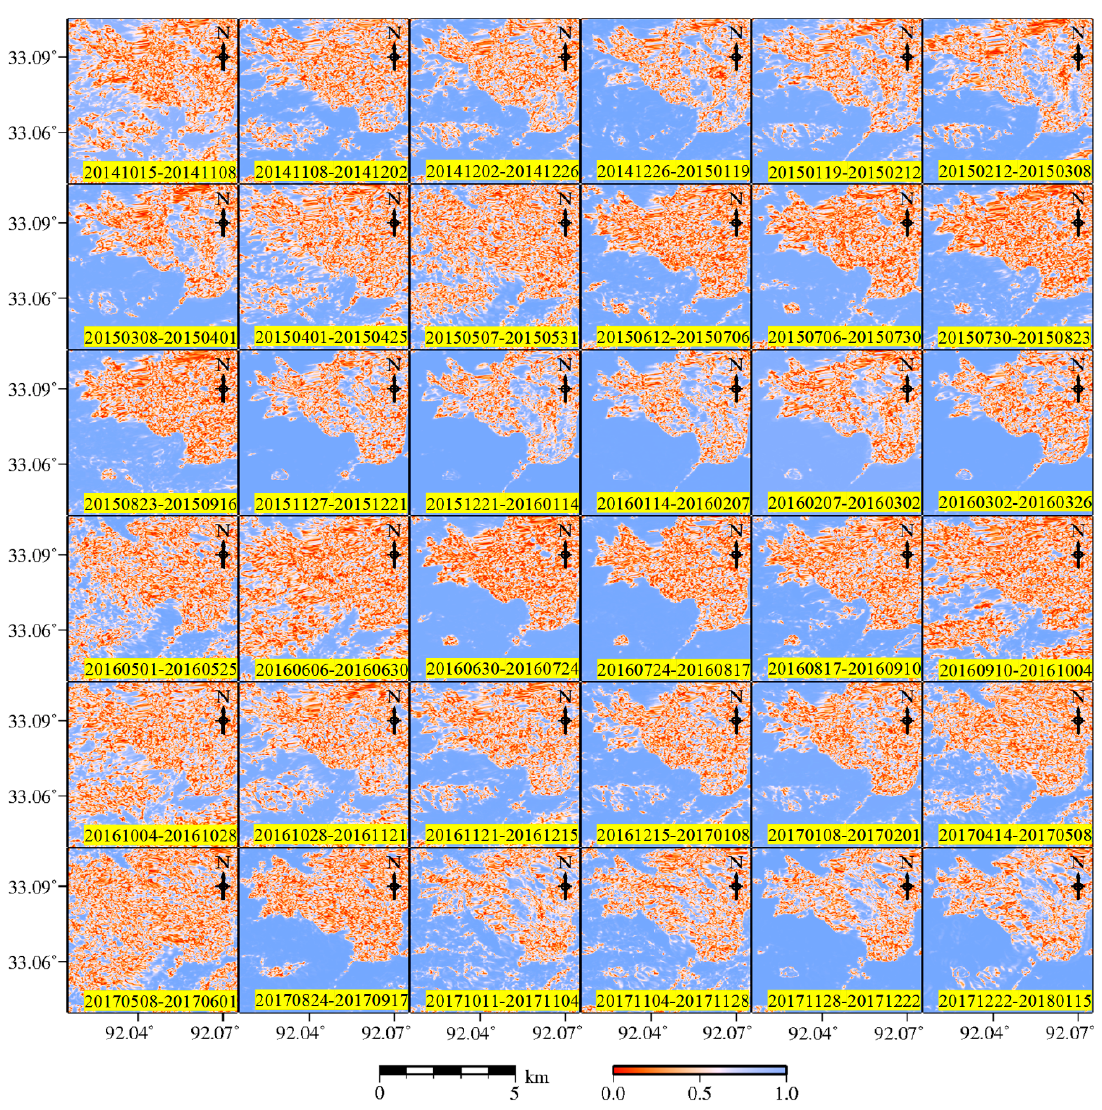
Figure 6. The results of 36 multi-temporal coherence maps corresponding to the 36 Sentinel-1A InSAR pairs (see Table 2) spanning between 15 October 2014 and 15 January 2018. The scale bar at the bottom indicates the distance range of 5 km, while the color bar indicates the coherence level ranging from 0 to 1. The region with low coherence level (close to 0) presents the DDG.